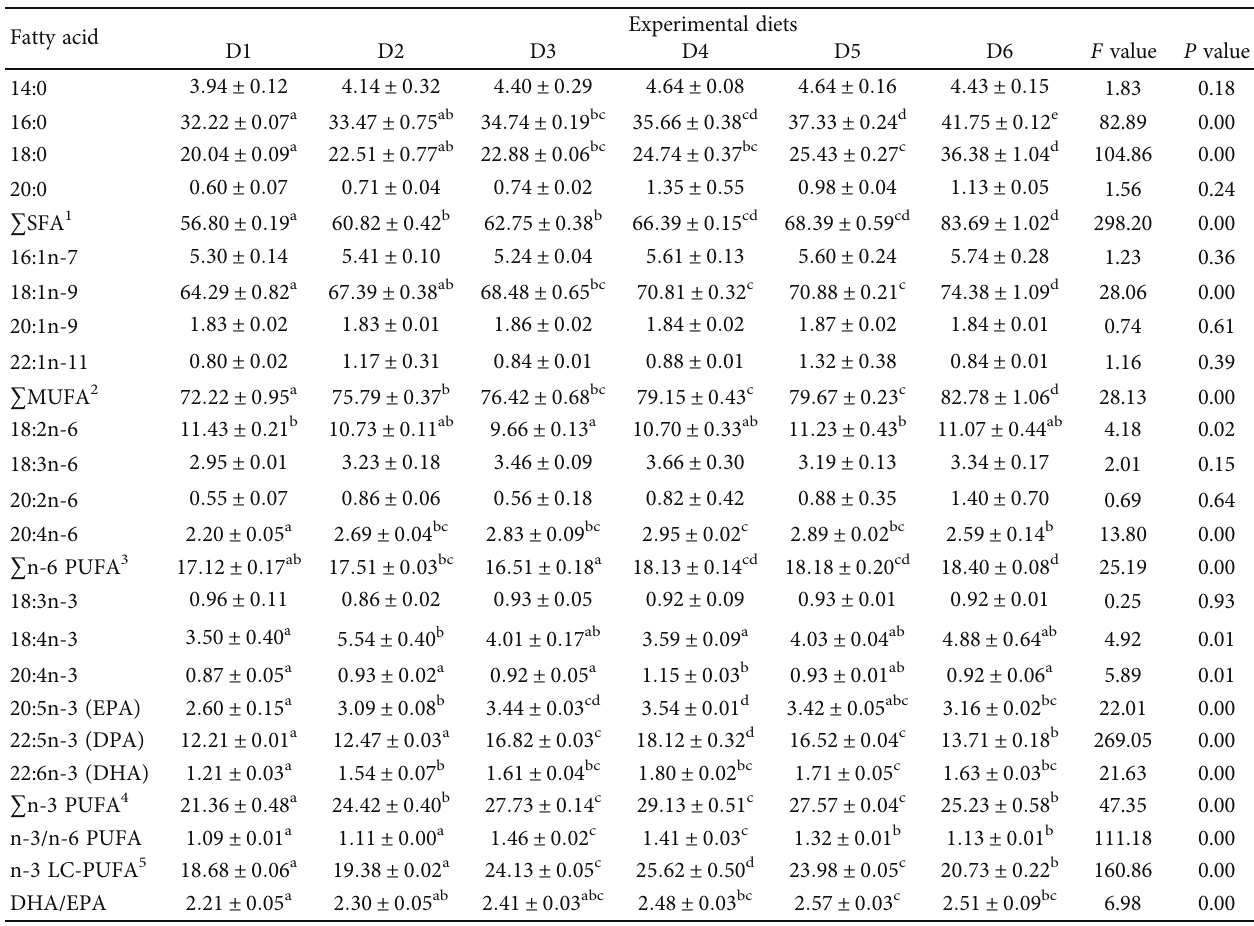
Table 5: E ff ects of dietary lipid levels on fatty acid composition (mg/g, dry matter) in the liver of juvenile Acanthopagrus schlegelii reared at low-salinity